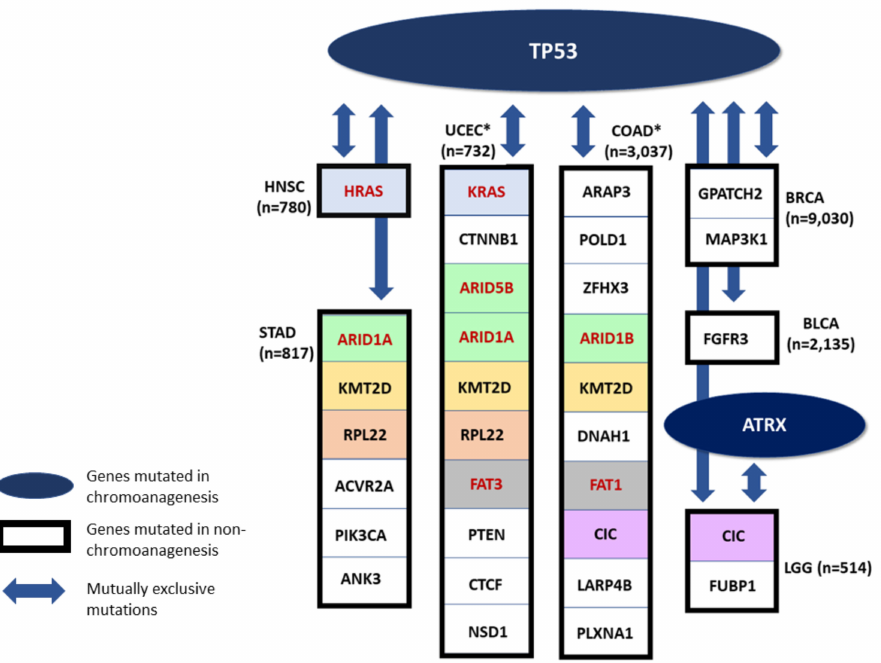
Figure 6. Mutually Exclusive Genes. A schematic presenting mutual exclusivity analysis for chro- moanagenesis differentially impaired genes. TP53 and ATRX (in LGG) are significantly more impaired in chromoanagenesis, and are also mutually exclusive from genes significantly more impaired in non-chromoanagenesis individuals. Only genes with mutual exclusivity q -value < 0.005 are shown. Genes that appear in more than one cancer type are indicated by the same background color. Paralo- gous genes are marked with red font and colored with a similar background. * Only the top 10 genes are shown, for cancer types with more differentially-impaired, mutually-exclusive genes. Many of these mutually exclusive relationships were previously detected and